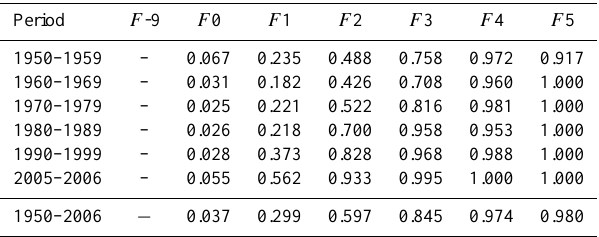
Table 2. Relative number of tornadoes with atmospheric moments M ≥ 10 10 J relative to the observed tornadoes per Fujita class ( F 0– F 5). For unrated tornadoes F -9 no moments were calculated, source: SPC, period: 1950–2006.